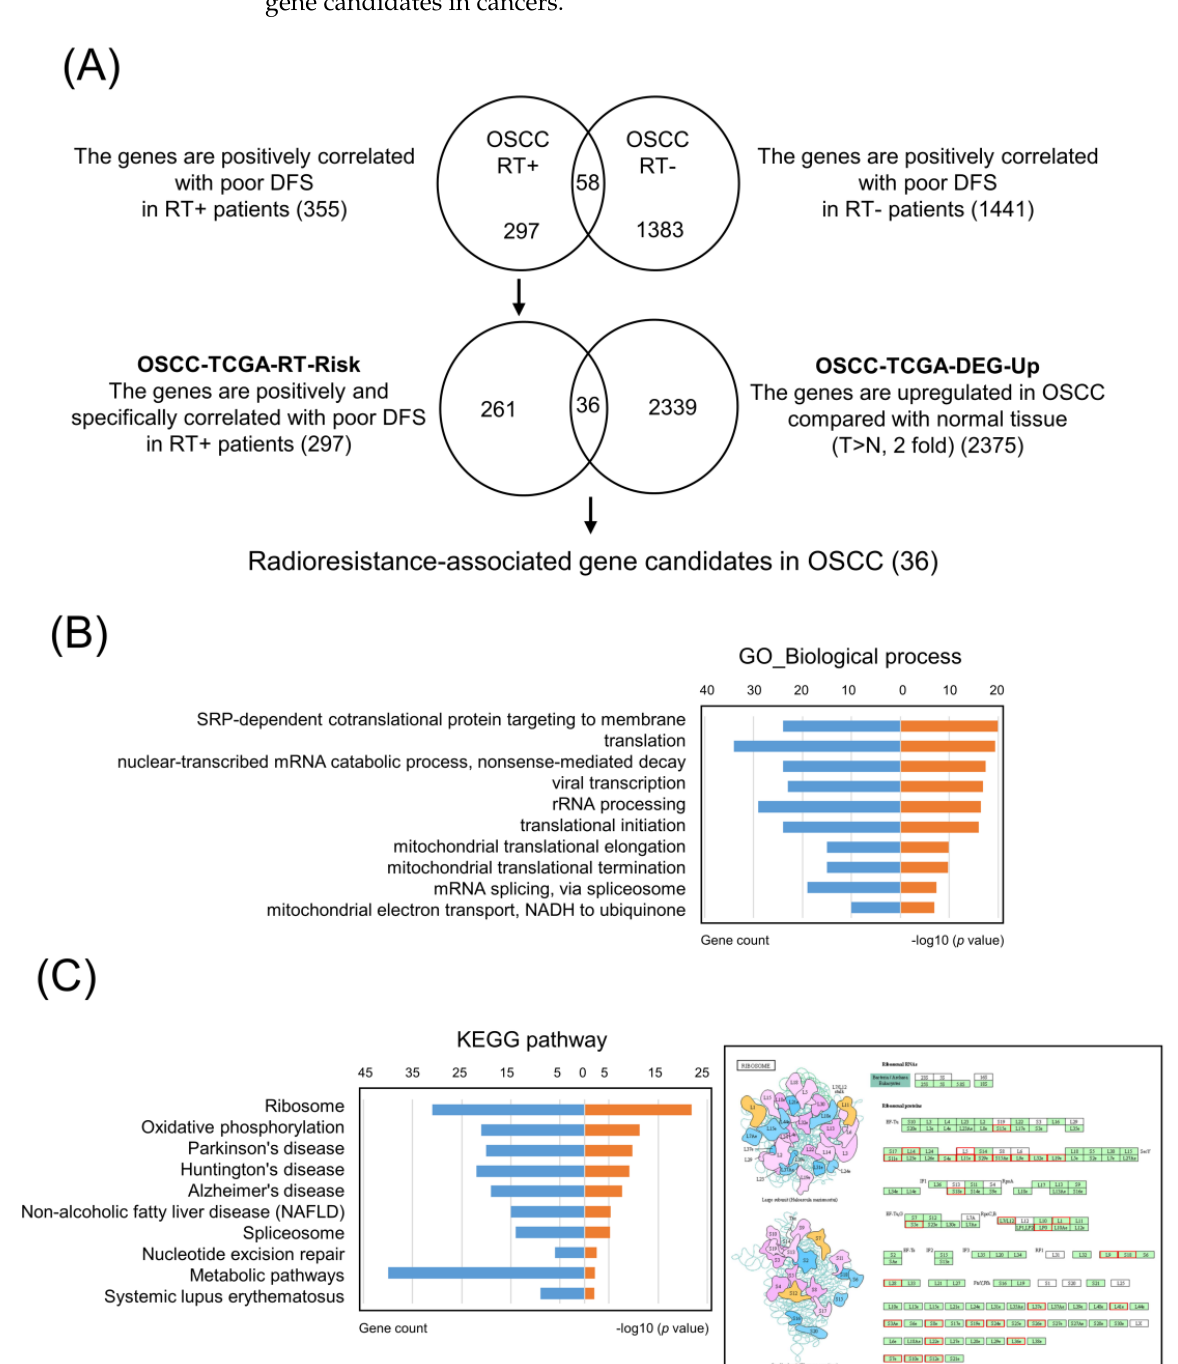
Figure 1. Identification of specific radioresistance-associated and upregulated gene candidates for OSCC from the TCGA dataset: ( A ) Schematic diagrams show the workflow design for profiling radioresistance-associated gene candidates in OSCC via comparative analysis of the TCGA dataset. Enrichment analysis of the 297 genes associated with radioresistance in OSCC; ( B ) significantly enriched GO biological process annotations; ( C ) significantly enriched KEGG pathways (left). KEGG pathway annotations of the ribosome pathway (right). The nodes indicated in red represent genes with high expression associated with poor DFS.